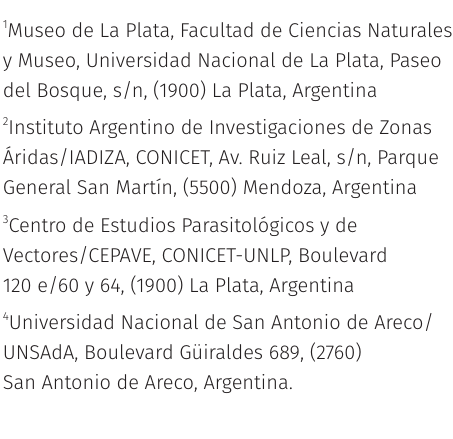
Table SI. Species of Curculionidae collected by pit-fall trapping in lettuce and tomato crops, conventionally (CM) or organically (OM) managed, in spring-summer (SS) or fall-winter (FW) cycles, in Northern Buenos Aires province. Years: 2010-2013. Table SII. Species of Carabidae collected by pit-fall trapping in lettuce and tomato crops, conventionally (CM) or organically (MO) managed, in spring-summer (SS) or fall-winter (FW) cycles, in Northern Buenos Aires province. Years: 2010-2013. Table SIII. Species of Staphylinidae collected by pit-fall trapping in lettuce and tomato crops, conventionally (MC) or organically (MO) managed, in spring-summer (SS) or fall-winter (FW) cycles, in Northern Buenos Aires province. Years: